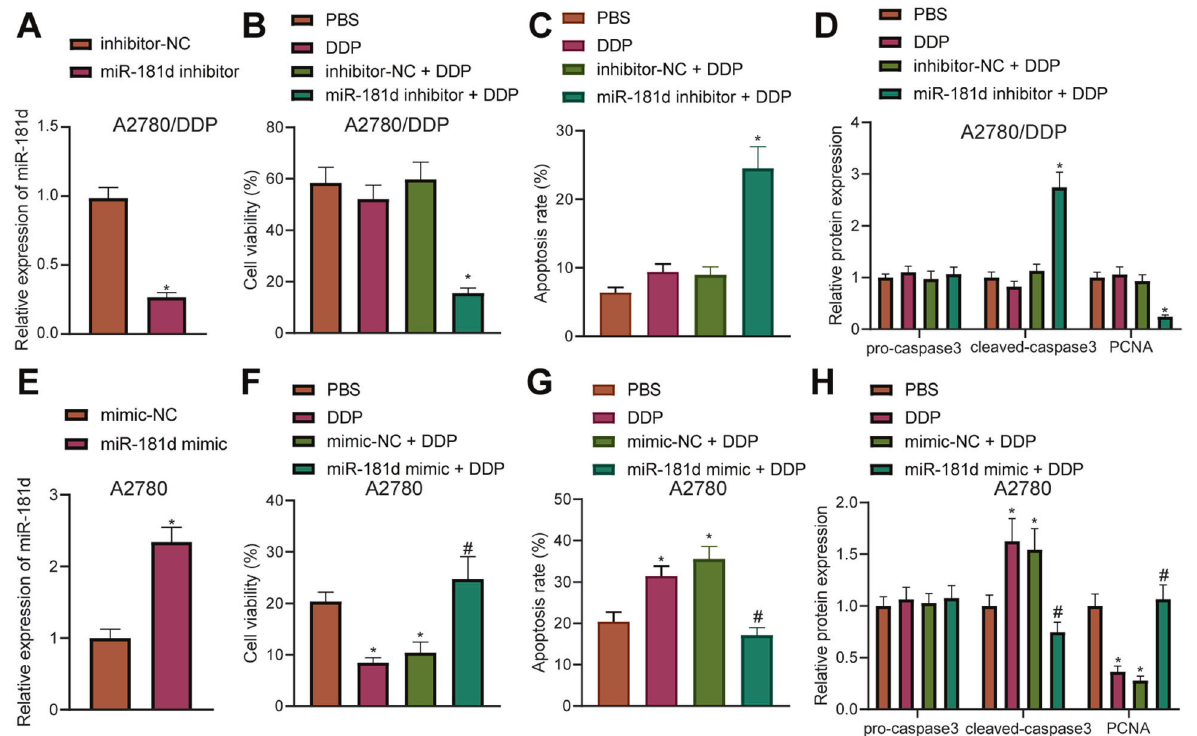
Fig. 2 miR-181d promotes resistance of OC cells to DDP. A RT-qPCR detection of miR-181d expression in A2780/DDP cells after miR-181d inhibitor treatment normalized to U6. B CCK-8 assay of viability of A2780/DDP cells after miR-181d inhibitor treatment. C Flow cytometric analysis of A2780/DDP cell apoptosis after miR-181d inhibitor treatment in the presence or absence of DDP treatment. D Western blot assay of apoptosis-related proteins pro-caspase3, cleaved caspase-3, and proliferation-related protein PCNA in A2780/DDP cells normalized to β -actin after miR-181d inhibitor treatment. E RT-qPCR detection of miR-181d expression in A2780 cells after miR-181d mimic treatment normalized to U6. F CCK-8 assay of viability of A2780 cells after miR-181d mimic treatment. G Flow cytometric analysis of A2780 cell apoptosis after miR-181d mimic treatment in the presence or absence of DDP treatment. H Western blot assay of apoptosis-related proteins pro-caspase3, cleaved caspase-3, and proliferation-related protein PCNA in A2780 cells after miR-181d mimic treatment. Cell experiments were repeated three times independently. * p < 0.05 versus A2780/DDP cells treated with inhibitor-NC or A2780 cells treated with